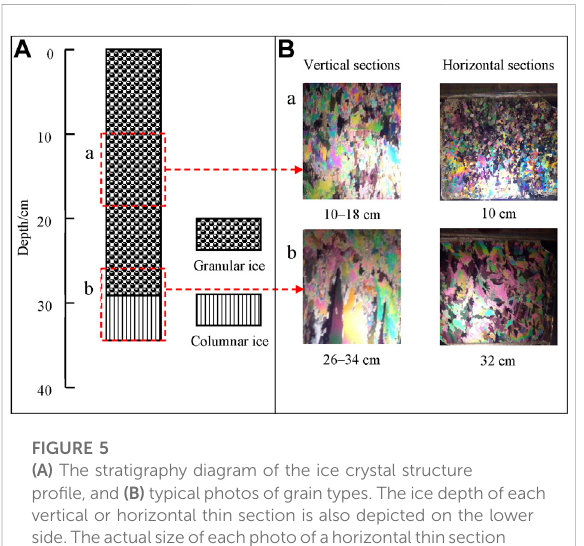
FIGURE 6 Experiment equipment for the three-point bending test: (A) hydraulic system; (B) aluminum plate; (C) force sensor; (D) line- load pressing plate; (E) laser displacement sensor (behind the ice sample); and (F) simply supported